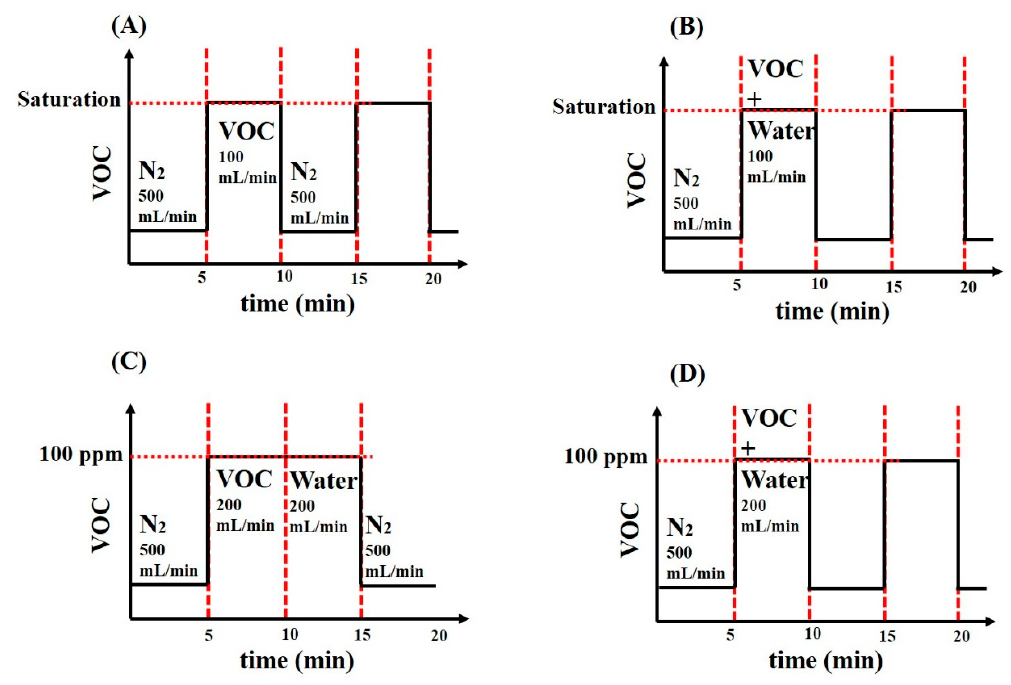
Figure 1. Experimental setup for the evaluation of the effects of water on vapor sensing properties: ( a ) Test of single flows of saturated solvents, ( b ) Test of flows of water and solvents in saturated conditions mixed in parallel, ( c ) Test of flows of water and solvents at 100 ppm (part per million) mixed successively, ( d ) Test of flows of water and solvents at 100 ppm mixed in parallel.